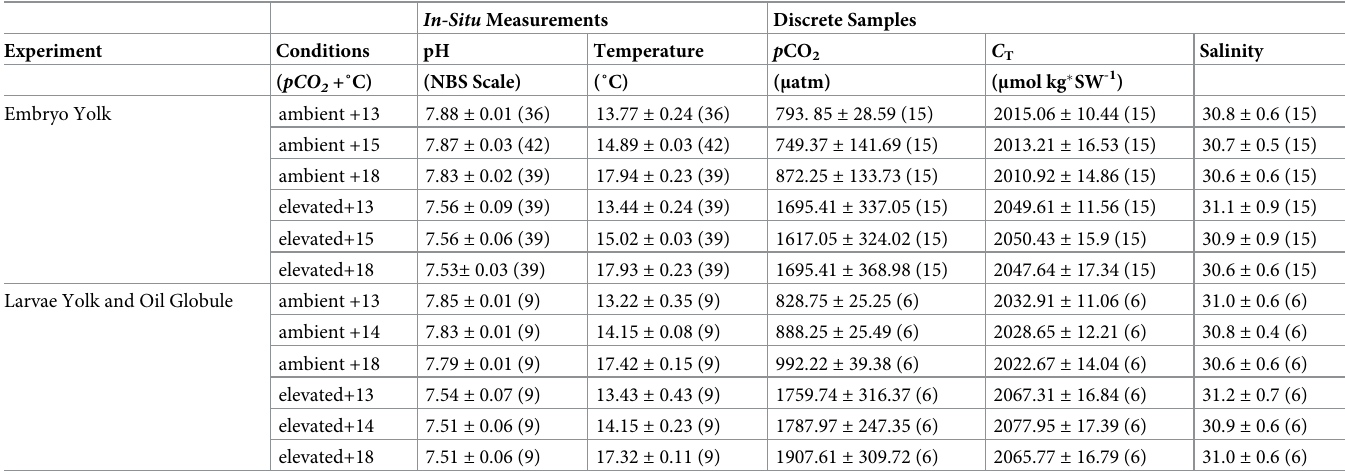
Table 1. Treatment conditions.